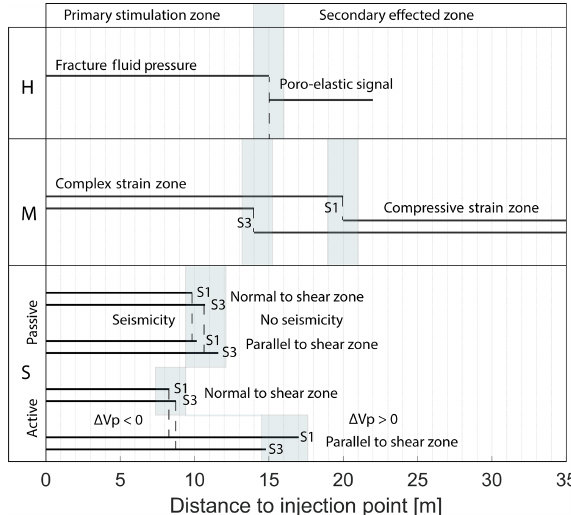
Figure 14. Comparison of radial extension stimulated zones deter- mined by hydraulics (H), deformation (M) and seismics (S). For the seismic observations, we distinguish between active seismics (ve- locity changes) and passive seismics (located seismic events). Note that we did not distinguish between measurement directions for the H and M estimates, as we did not have enough measurement loca- tions to resolve them